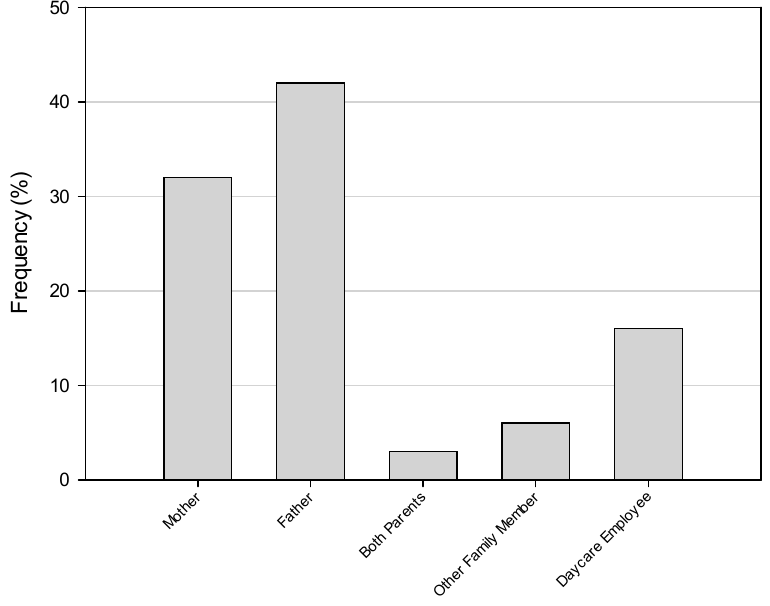
Figure 1. Incidents of children left unattended in motor vehicles by responsible caregiver.